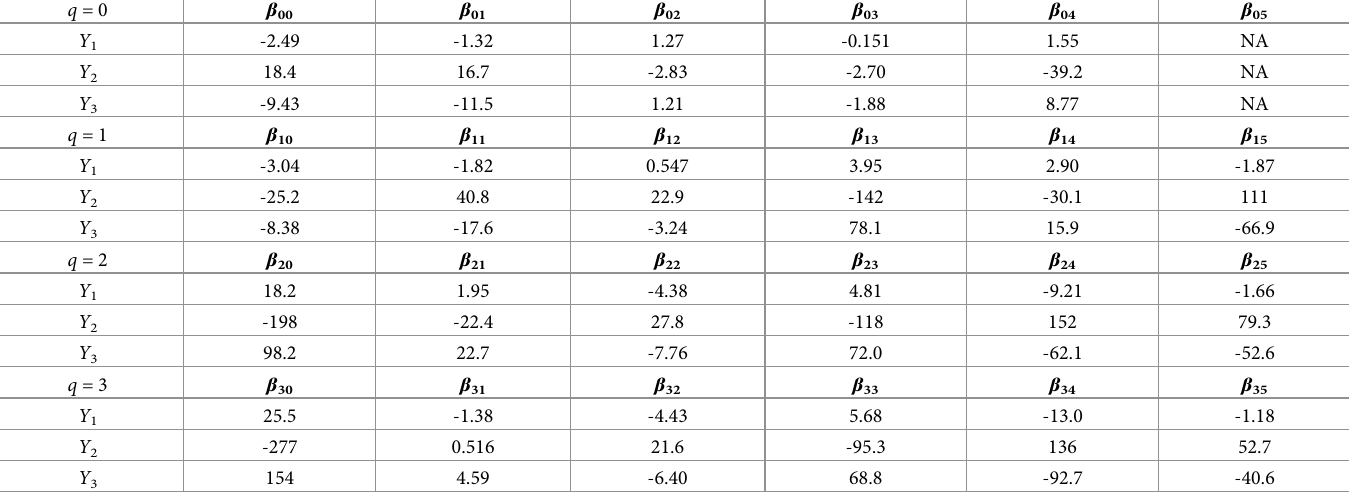
Table 6. Coefficients for Model C-Outdoor. Y 1 , Y 2 , and Y 3 represent Δ E , Δ Gloss 60 , and Δ Haze , respectively. q is the natural spline basis function counter for UVA < 360